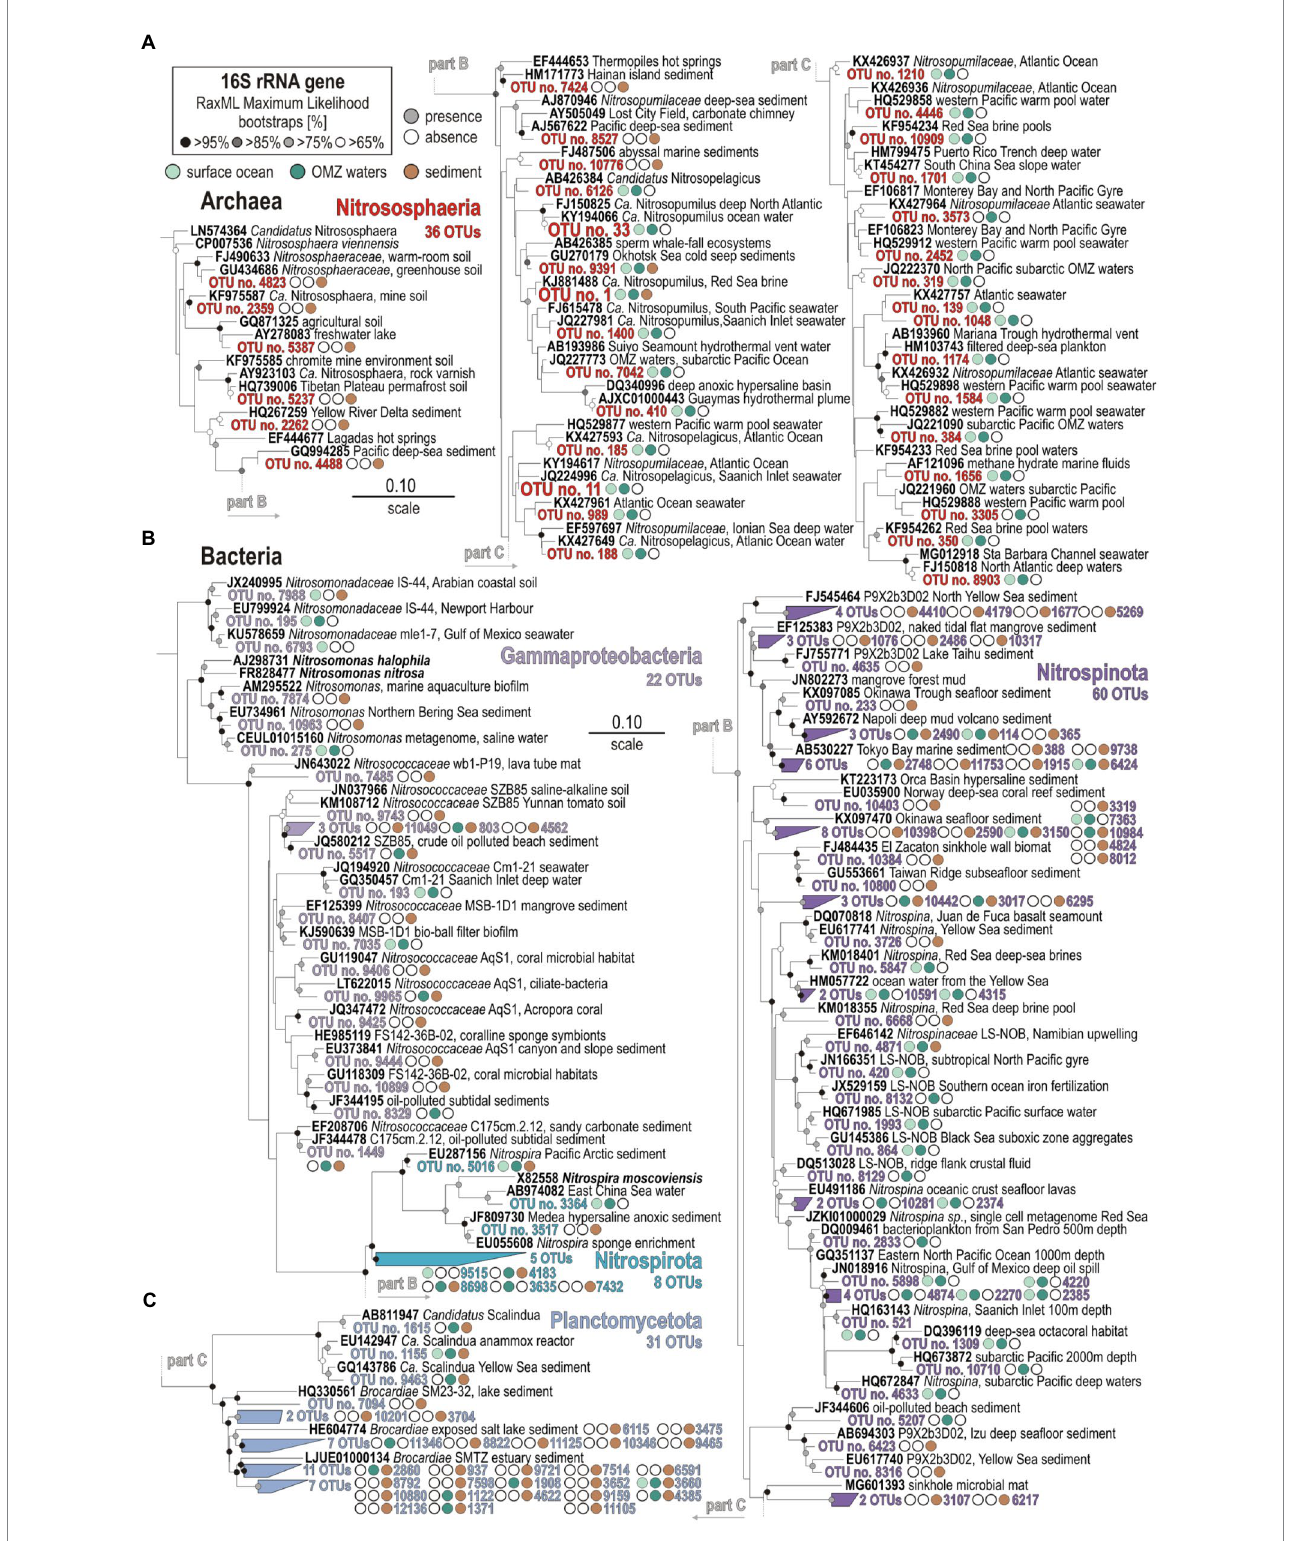
FIGURE 3 Phylogenetic analysis of partial 16S rRNA gene amplicons for ammonia-oxidizing archaea (A) , ammonia- and nitrite-oxidizing bacteria (B) , and anammox bacteria (C) . RAxML Maximum Likelihood archaeal and bacterial trees selected among 100 replicates for all partial 16S rRNA transcripts (V4 hypervariable region). Presence/absence of a 16S rRNA gene with the surface ocean (light green), OMZ waters (dark green), and sediment (brown) is signified by full vs. empty circles. Bold types signify accession numbers and cultivated species, whereas regular font indicates the sequence isolation